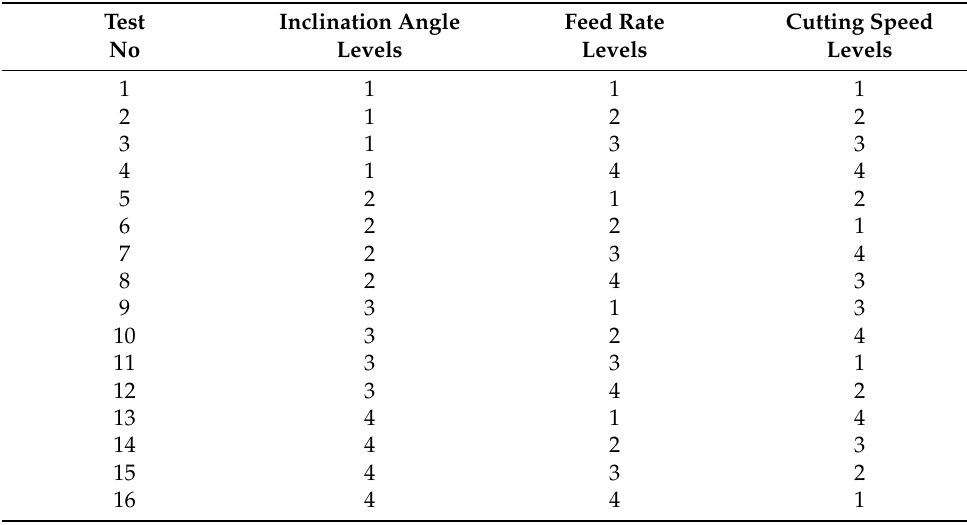
Table 3. The design of experiments for the machining runs.